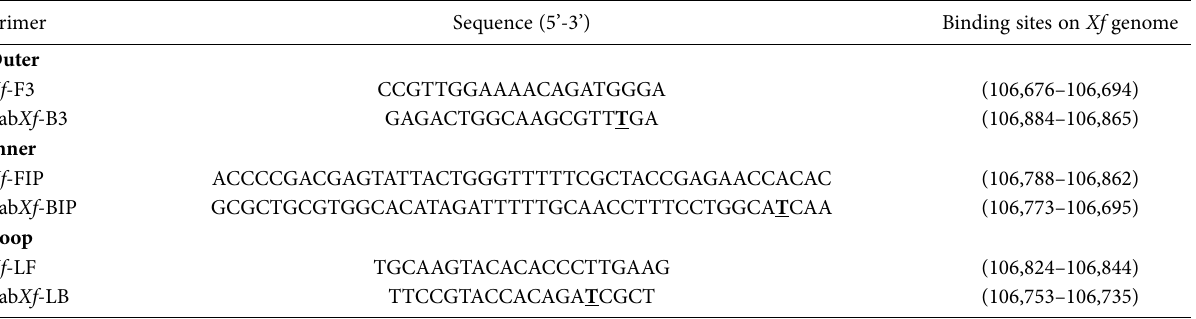
Table 1. Six primers of three categories (outer, inner and loop) used in the FLOS-LAMP assay. The internal thymine residues ( T ) at the 3’ terminus of primers for each category (B3, BIP, LB) were fluorescein-labeled. Primer Sequence (5’-3’) Binding sites on Xf genome